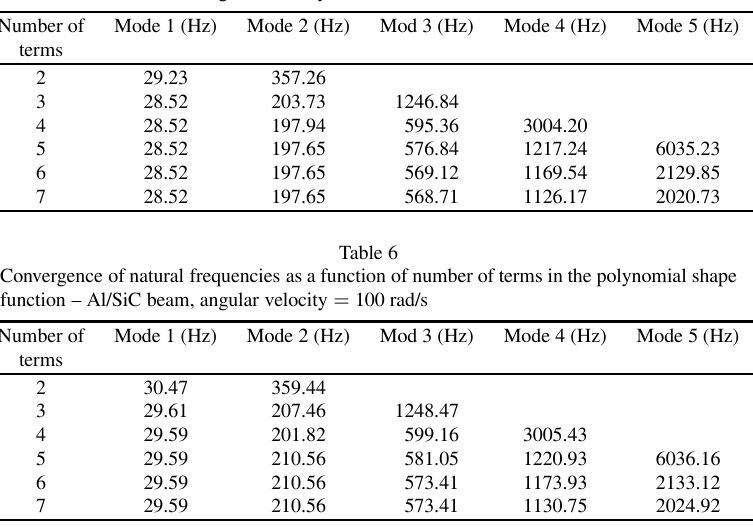
Table 5 Convergence of natural frequencies as a function of number of terms in the polynomial shape